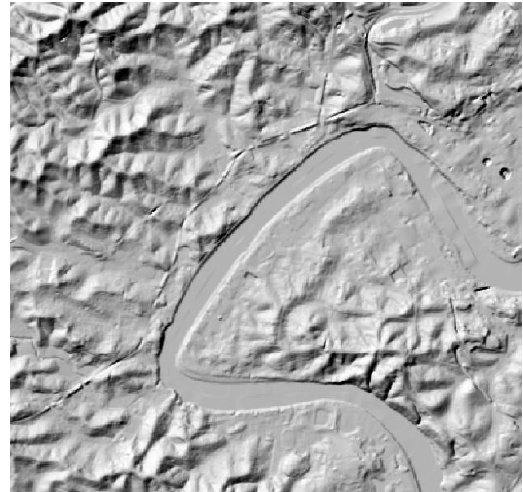
Figure 5. Ground surface model of the study site using a 5m x 5m